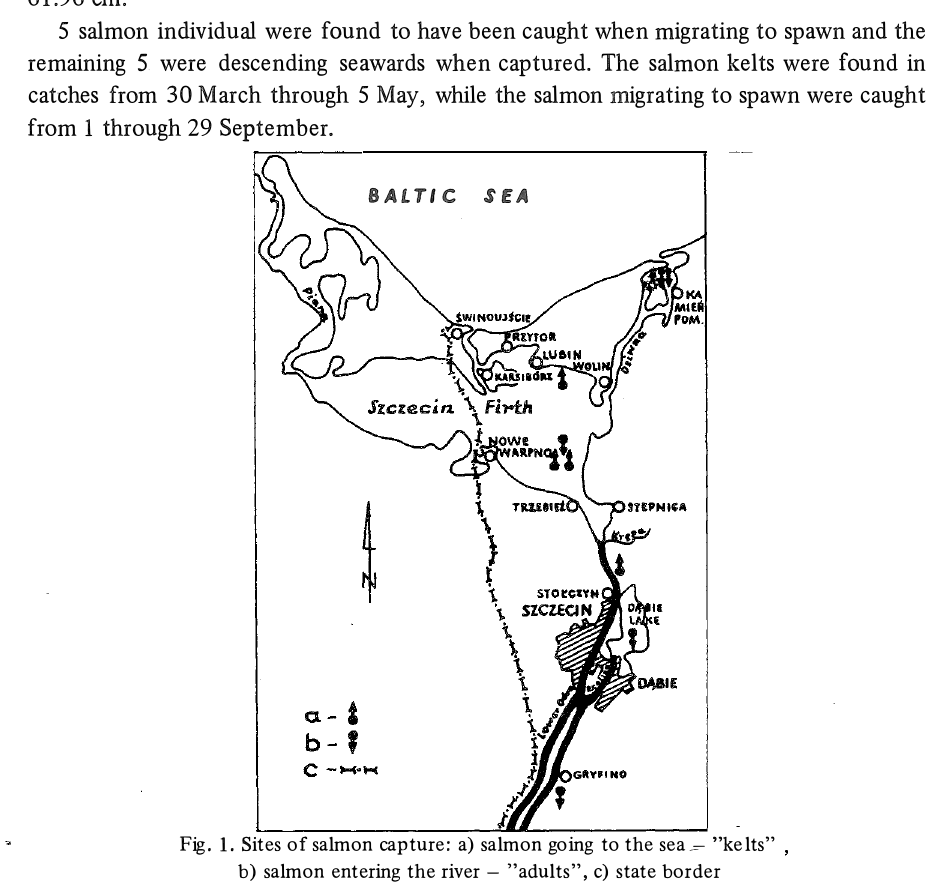
Fig. 1. Sites of salmon capture: a) salmon going to the sea.� "kelts" b)salmon entering the river -"adults", c) state